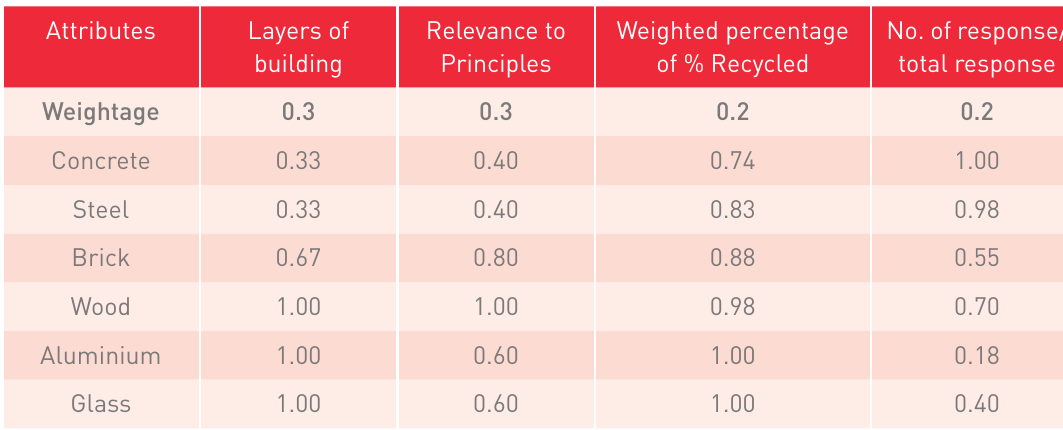
Relevance to Principles